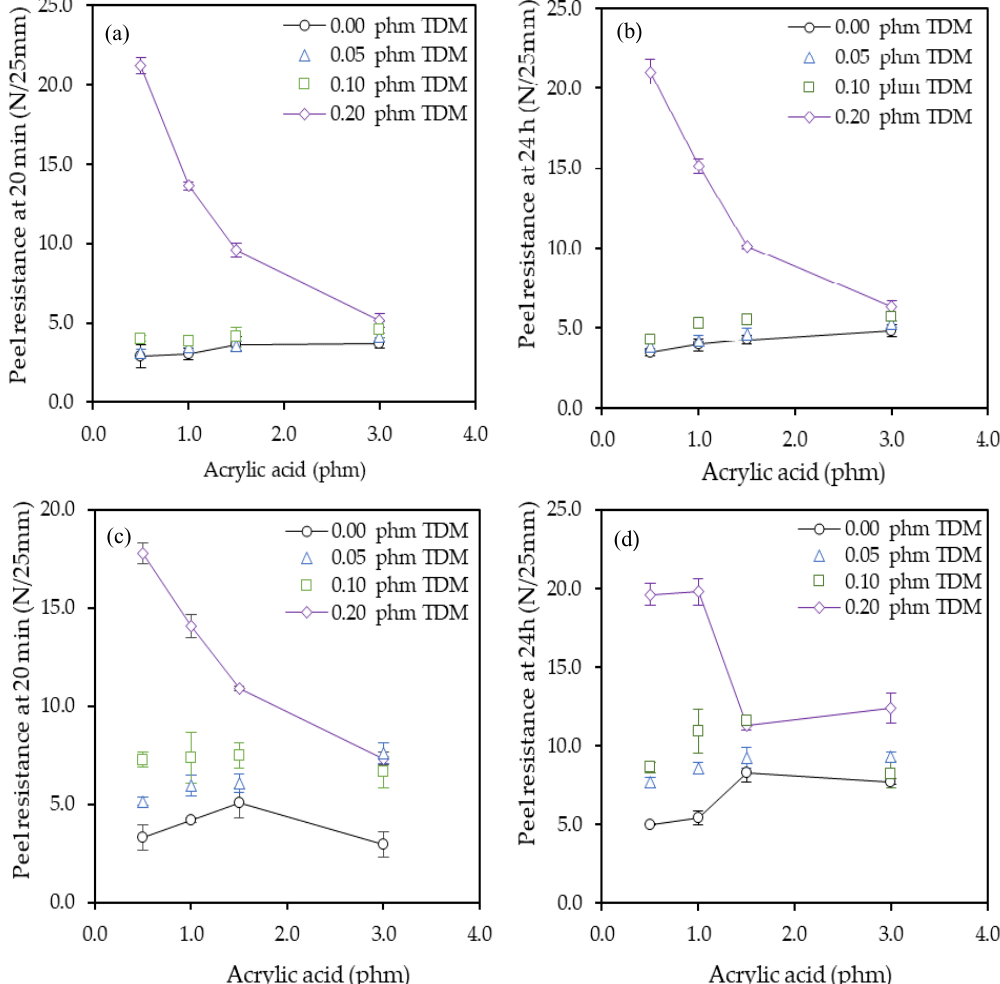
Figure 5. Experimental results of peel resistance at 20 min and 24 h (25 g / m 2 of adhesive) on glass panels for ( a ) and ( b ) polyethylene terephthalate (PET), and for ( c ) and ( d ) paper tapes.